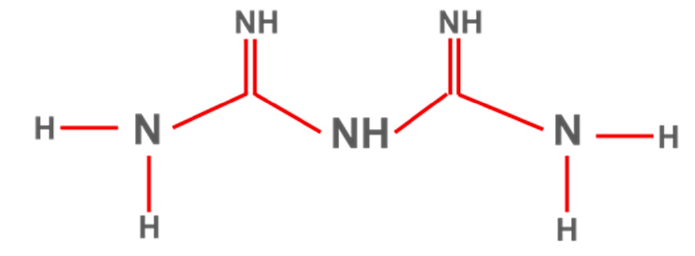
Figure 6. Metformin’s chemical structure.